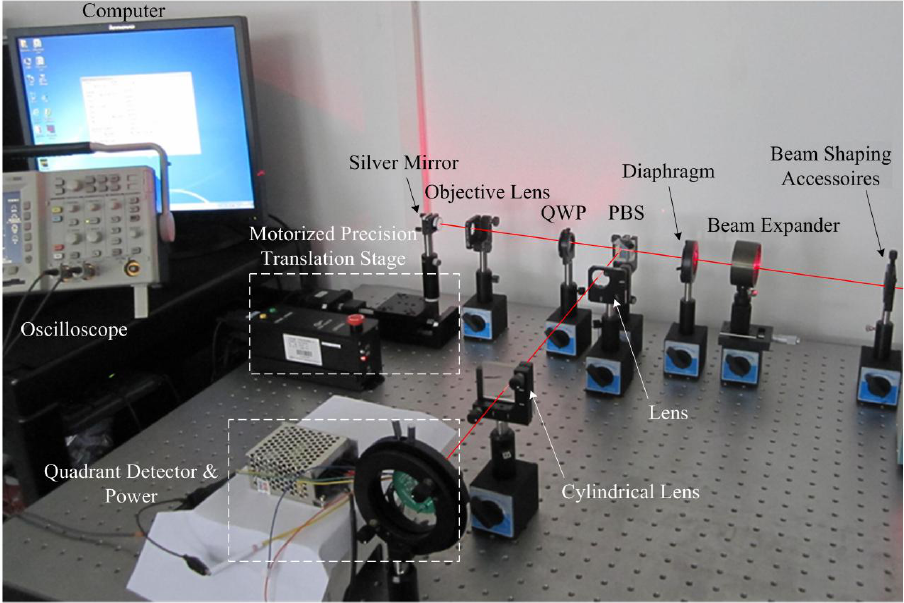
Figure 10. Experimental platform of light path for focusing servo beam.